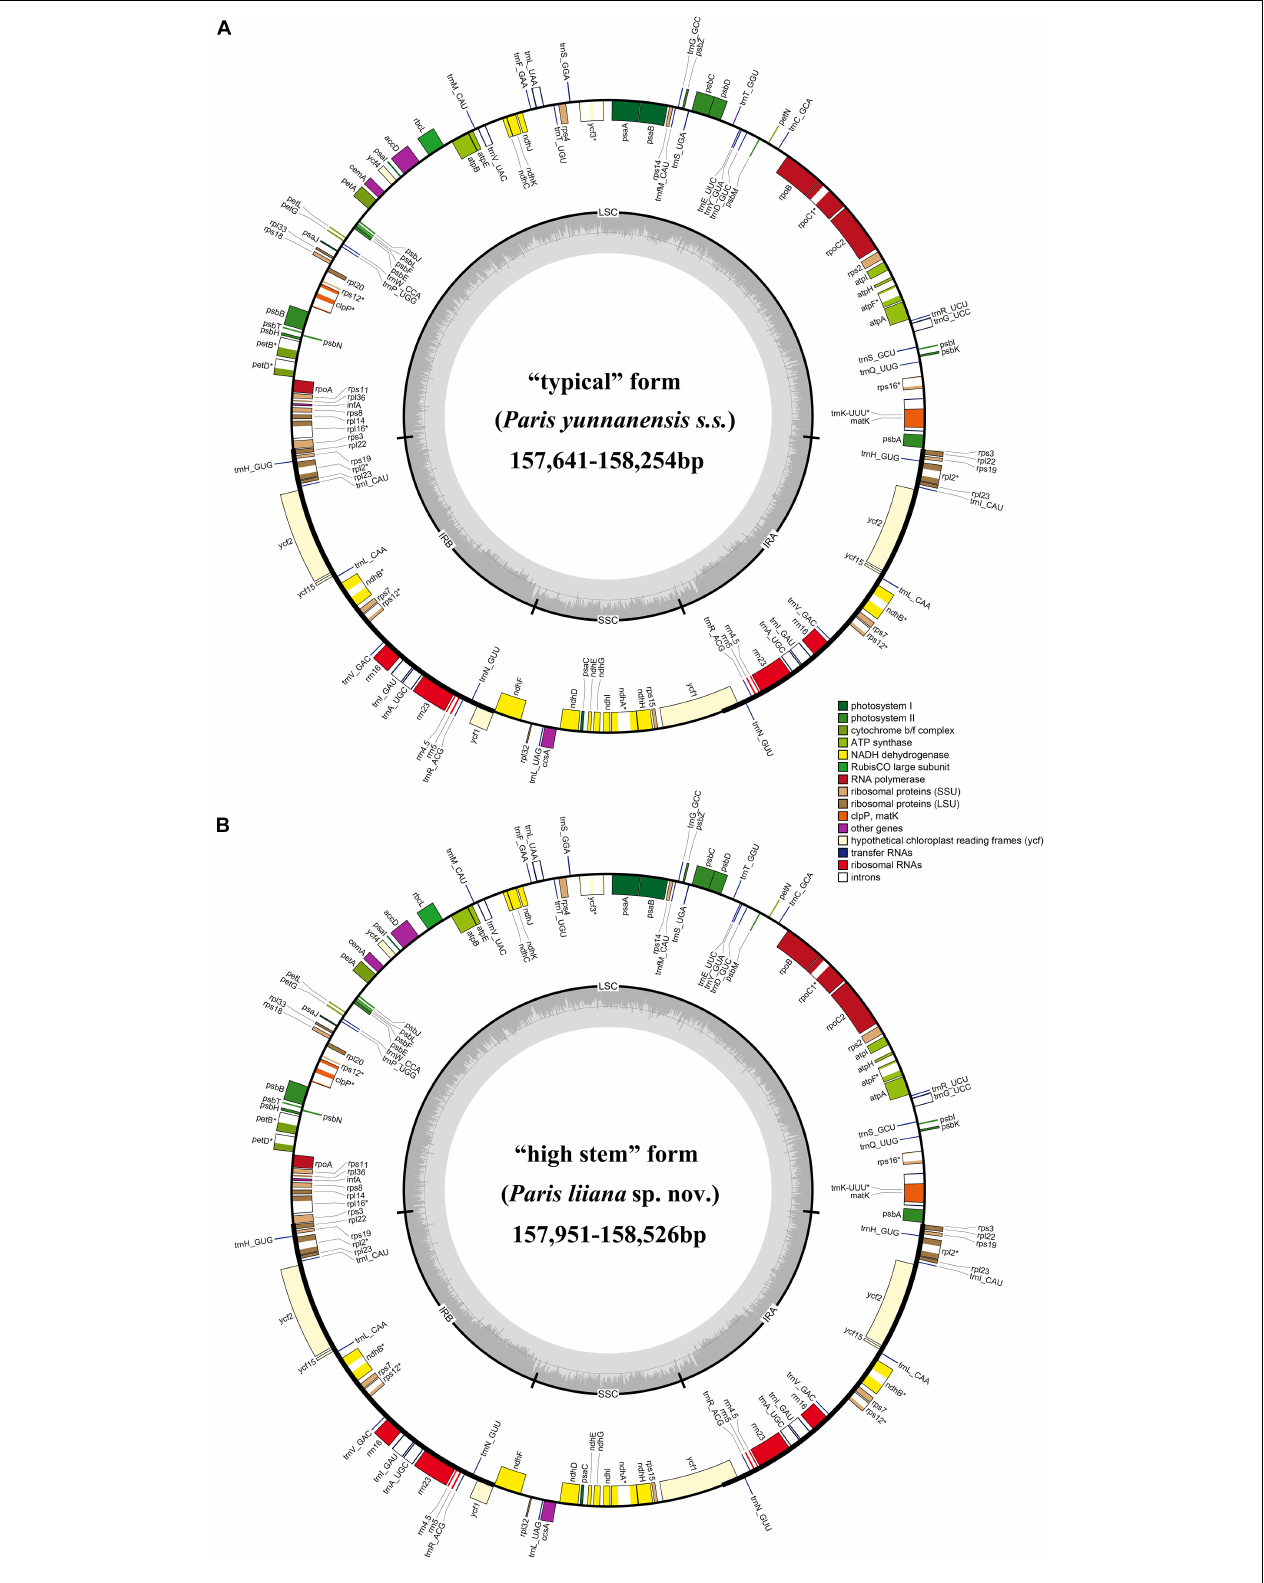
FIGURE 3 | The plastome map of “typical” Paris yunnanensis ( P. yunnanensis s.s. ) accessions (A) and “high stem” form ( P. liiana sp. nov) accessions (B) .